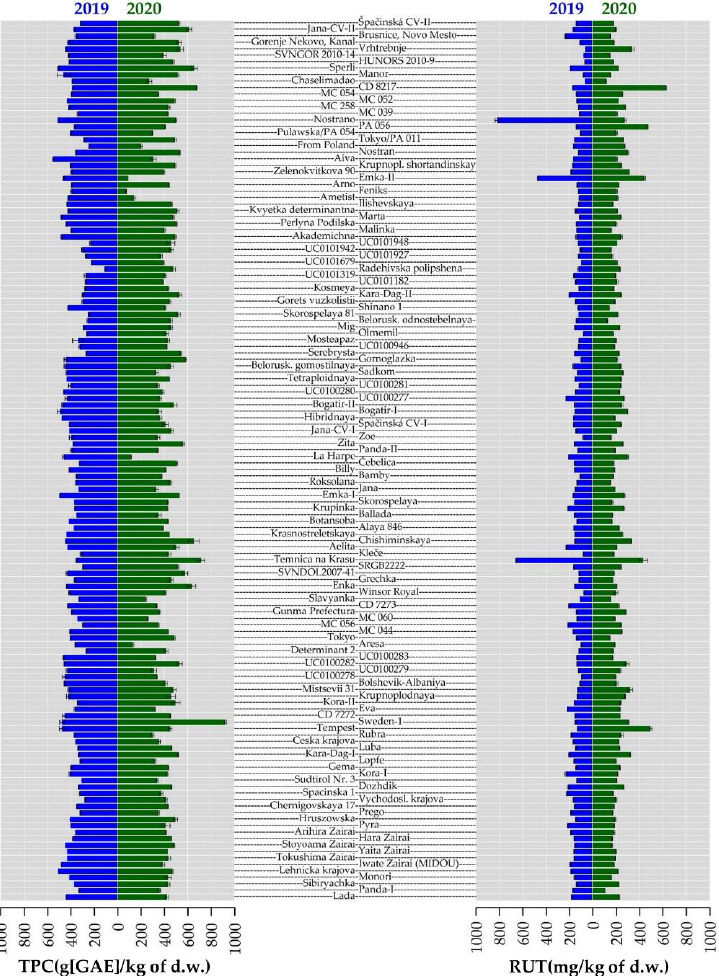
Figure 3. Total phenolic content (TPC) and rutin content (RUT) observed for the collection of 136 buckwheat genotypes. Blue and green bars represent the data from 2019 and 2020, respectively. The values are depicted as mean value from respective year ± standard deviation.